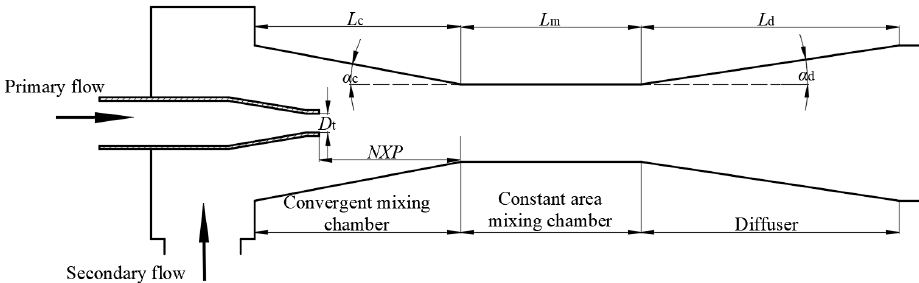
Figure 4. Schematic diagram of the ejector geometry.